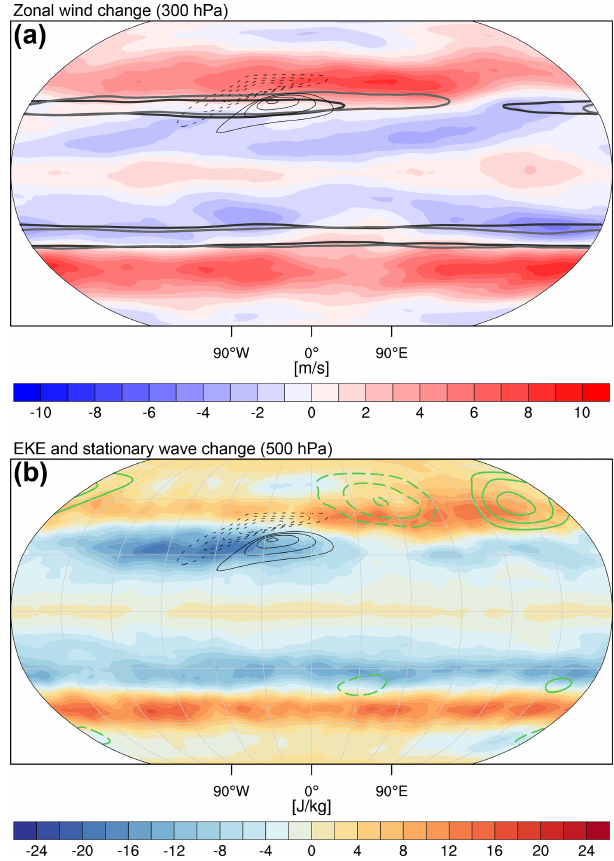
Figure D1. (a) Wind speed difference at 300hPa between the Qobs control run with SST front in the Northern Hemisphere and uni- form warming by 4K at the surface, as well as the 40ms − 1 wind speed contour in the control (black) and the warmed simulations (gray). (b) EKE (color) and geopotential difference at 500hPa (de- fined as deviation from the zonal mean; green solid indicate positive and dashed negative values; ± 200, 400, and 600m 2 s − 2 ). Addition- ally shown in both panels is the 2m temperature after removing the zonal mean (black solid contours indicate positive and dashed neg- ative values; starting at ± 2.5K in steps of